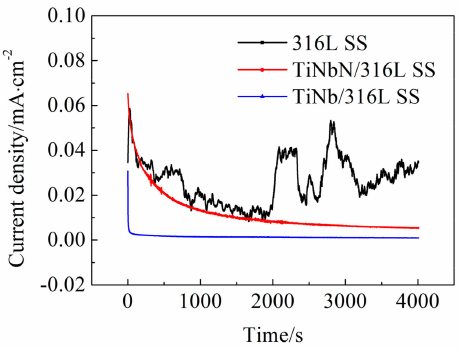
Figure 9. Potentiostatic polarization curves of 316L SS, TiNb / 316L SS, and TiNbN / 316L SS.